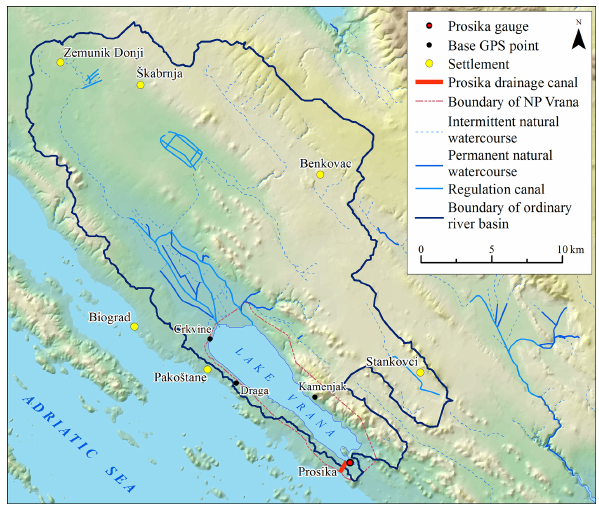
Figure 1. Study area with ordinary river